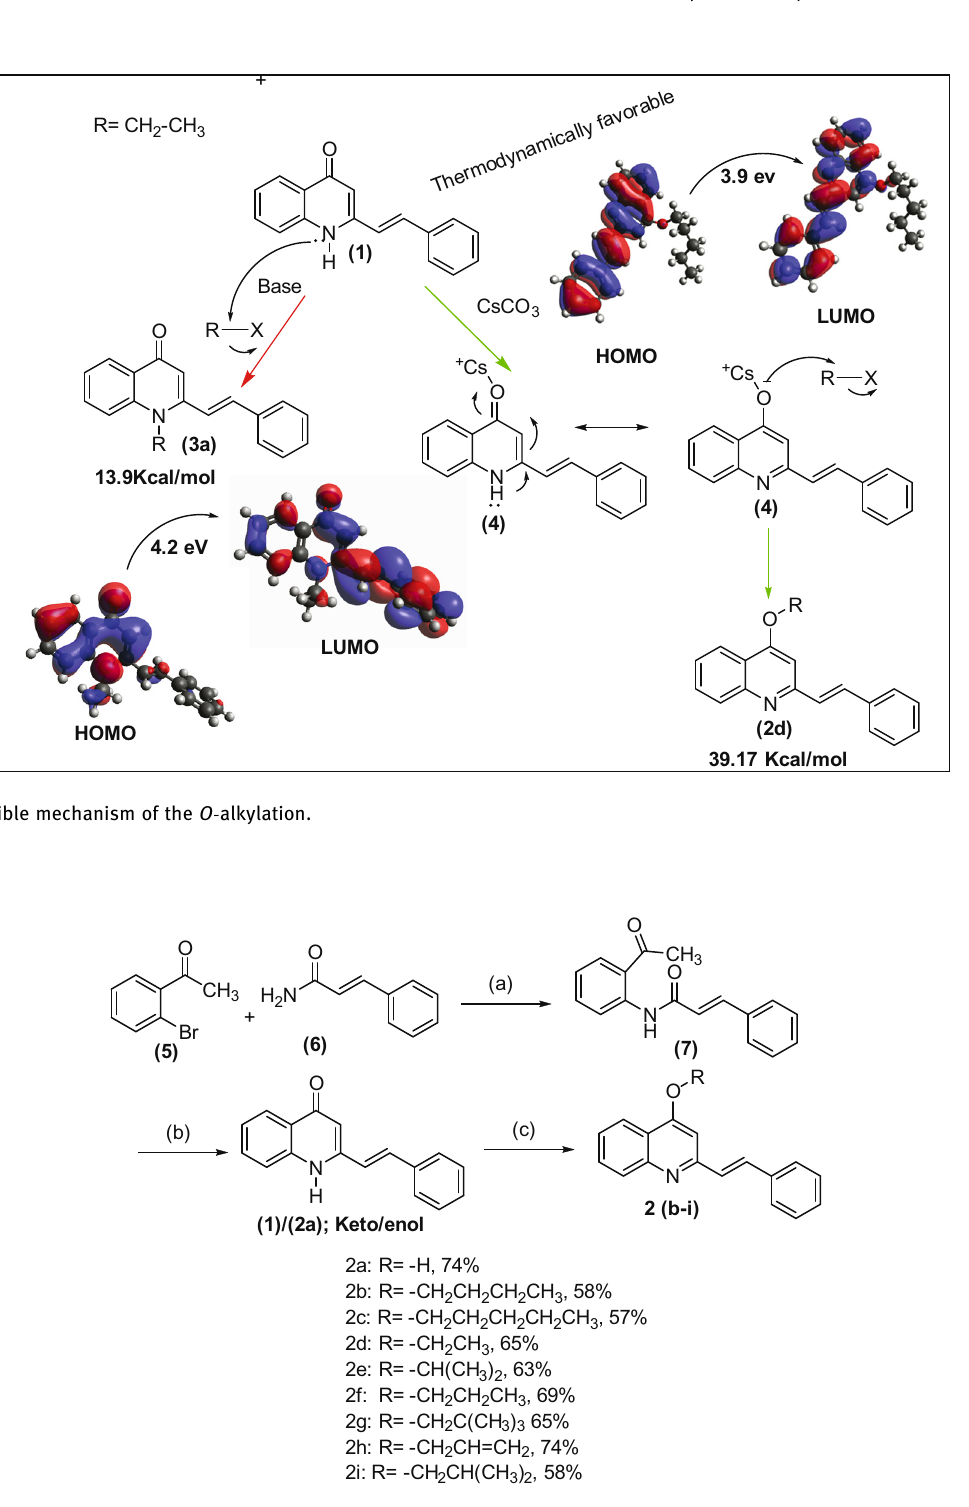
Scheme 1: Synthesis of 4 - substituted 2 - styryl quinoline derivatives ( 2a – i )